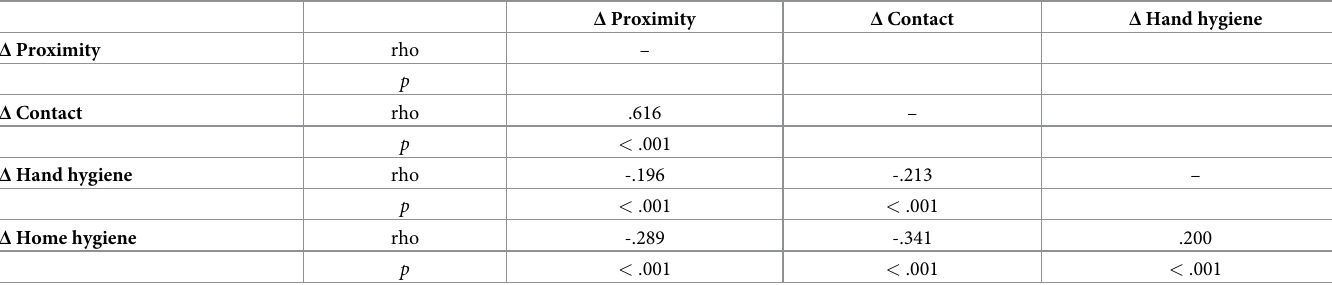
Table 3. Intercorrelations among mitigation change measures.